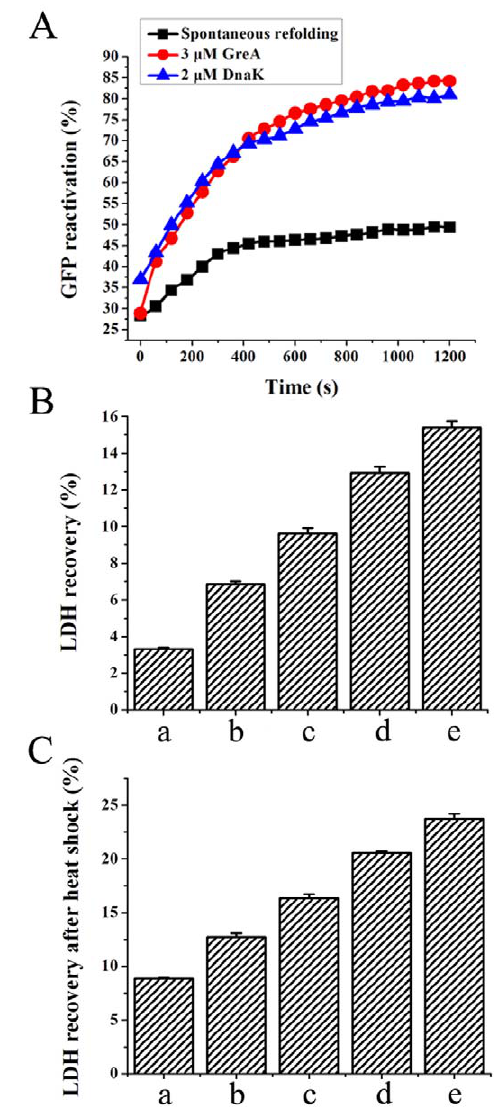
Figure 2. GreA facilitates protein reactivation from unfolded state. (A) GreA facilitates GFP refolding. GFP (100 m M) was denatured in 0.12 M HCl for 60 min and then diluted 100-fold. Spontaneous refolding or in the presence of 3 m M GreA or 2 m M DnaK was monitored using a Fluostar Optima microplate reader. (B) GreA promotes LDH refolding after GnHCl denaturation. LDH (15 m M) denatured by 6 M GnHCl was diluted 100-fold to start spontaneous refolding or GreA- facilitated refolding. (a) Control (b) 0.3 m M GreA (c) 0.6 m M GreA (d) 1.2 m M GreA (e) 1.2 m M DnaK. (C) GreA promotes LDH refolding after heat denaturation. 0.2 m M LDH was incubated at 50 u C for 80 min. After cooling down, 0.2 m M, 0.4 m M, 0.8 m M GreA or 0.5 m M DnaK was added to start refolding and the final concentration of LDH was adjusted to 0.1 m M. The enzymatic activity was detected after recovery for 30 min. (a) Control (b) 0.2 m M GreA (c) 0.4 m M GreA (d) 0.8 m M GreA (e) 0.5 m M DnaK.